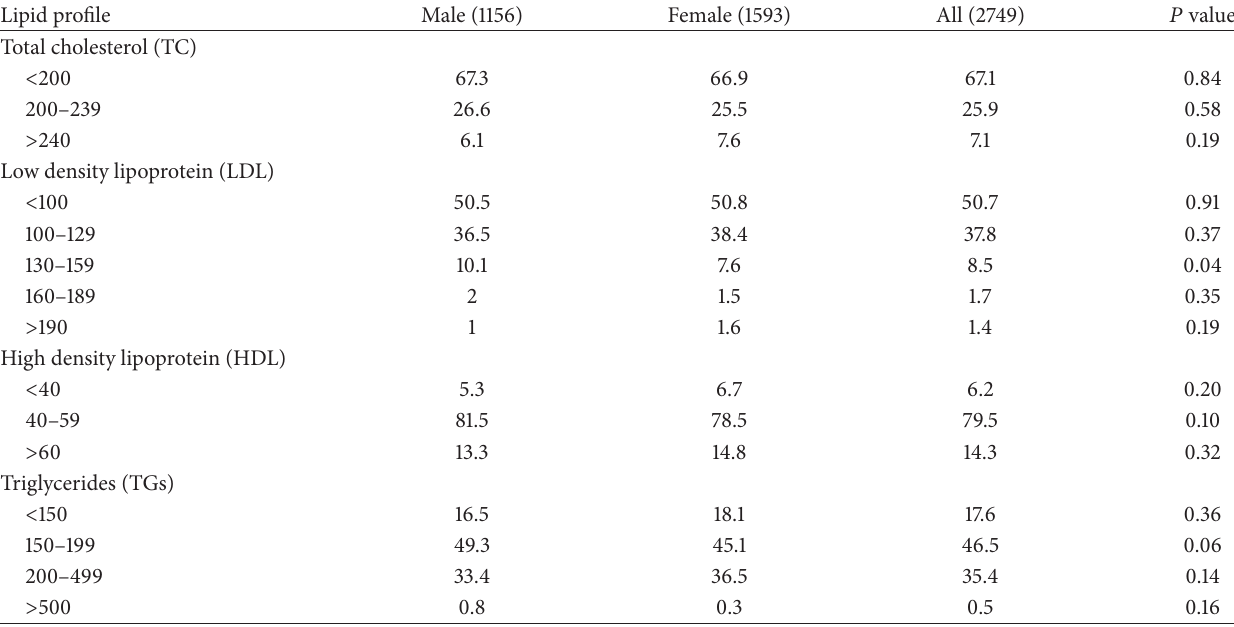
Table 5: Gender distribution of low density lipoprotein (LDL) of rural cohort for assessment of cardiovascular diseases (CVDs) risk factors in sub-Himalayan region of India,